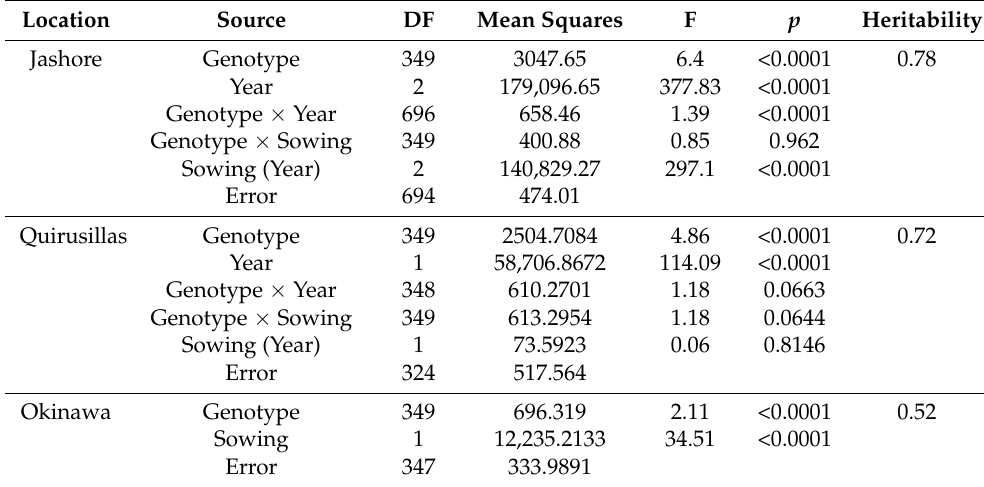
Table 1. Analysis of variance for wheat blast index in three locations and the corresponding heritability estimates.